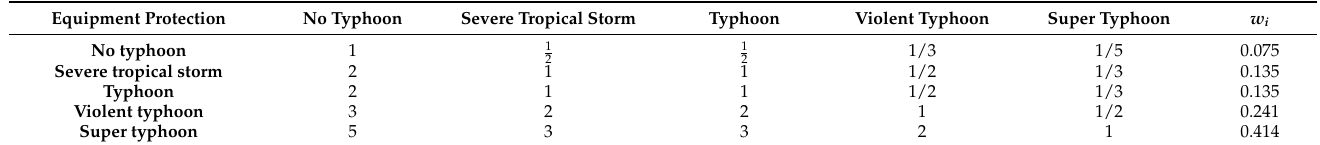
Table 8. The important degree judgment matrix of equipment protection under different typhoon intensity.